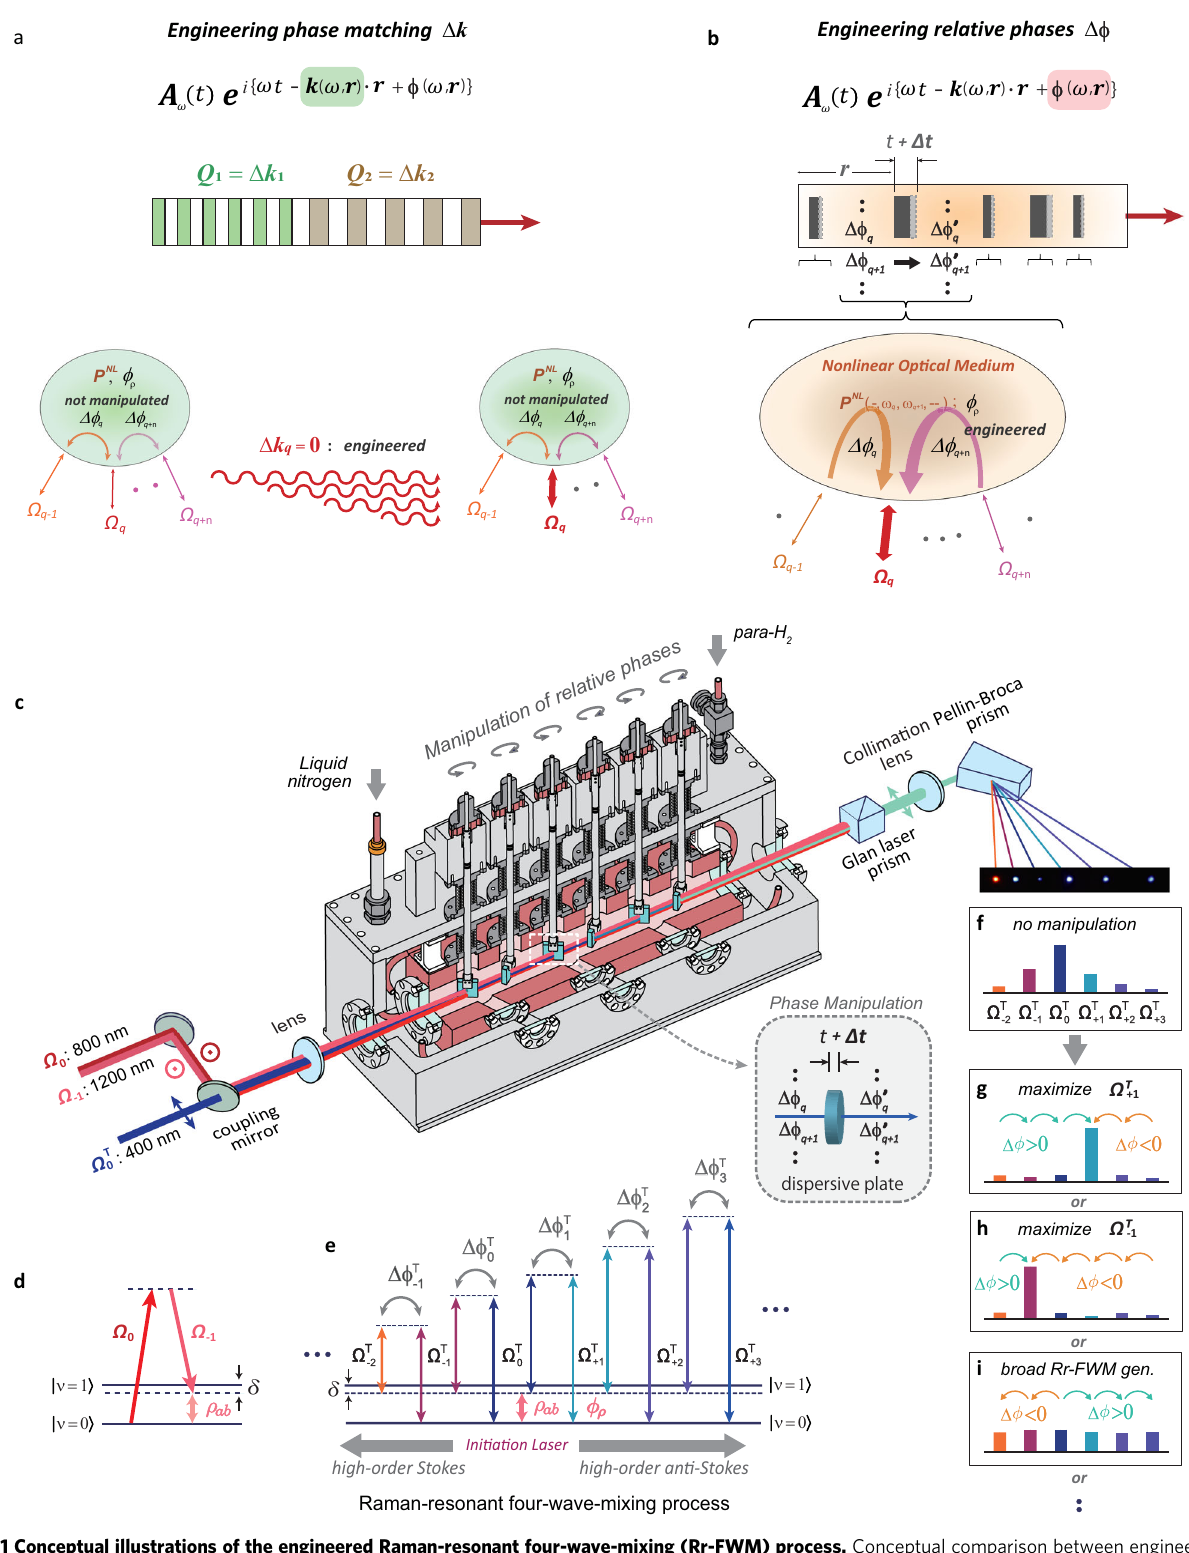
Fig. 1 Conceptual illustrations of the engineered Raman-resonant four-wave-mixing (Rr-FWM) process. Conceptual comparison between engineerings in nonlinear optical processes: a manipulation of the spatial phases, k ( ω , r ). b Manipulation of relative phases, ϕ ( ω , r ). c Schematics: the apparatus is a gas cell fi lled with gaseous para-hydrogen and cooled to 77 K by liquid nitrogen. Six dispersive plates (fused silica) are inserted in the interaction region, where the relative phases, Δ ϕ T q , are manipulated by precise control of the effective optical thicknesses of the plates. d Scheme of the adiabatic excitation of the vibrational coherence, ρ ab , at a pure vibrational Raman transition of ν 00 ¼ 1 j i radiation, Ω T . The relative phases, Δ ϕ T q , dominate the photon fl ow between the adjacent Raman modes, Ω T q and Ω T q (cid:1) 0 anti-Stokes generations in the engineered Rr-FWM processes by manipulating the relative phases, Δ ϕ T q ; f no manipulation applied; g , h output energy accumulations onto a speci fi c Raman mode; and i broad comb-like